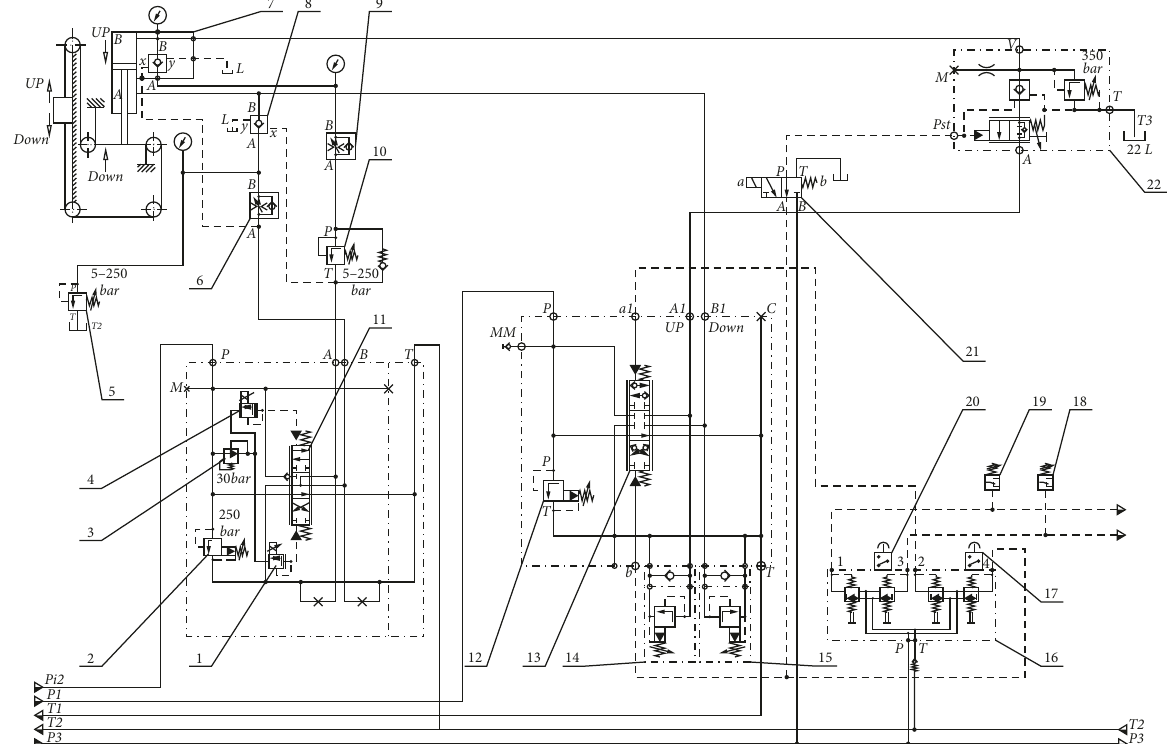
Figure 1: Schematic diagram of power head floating control